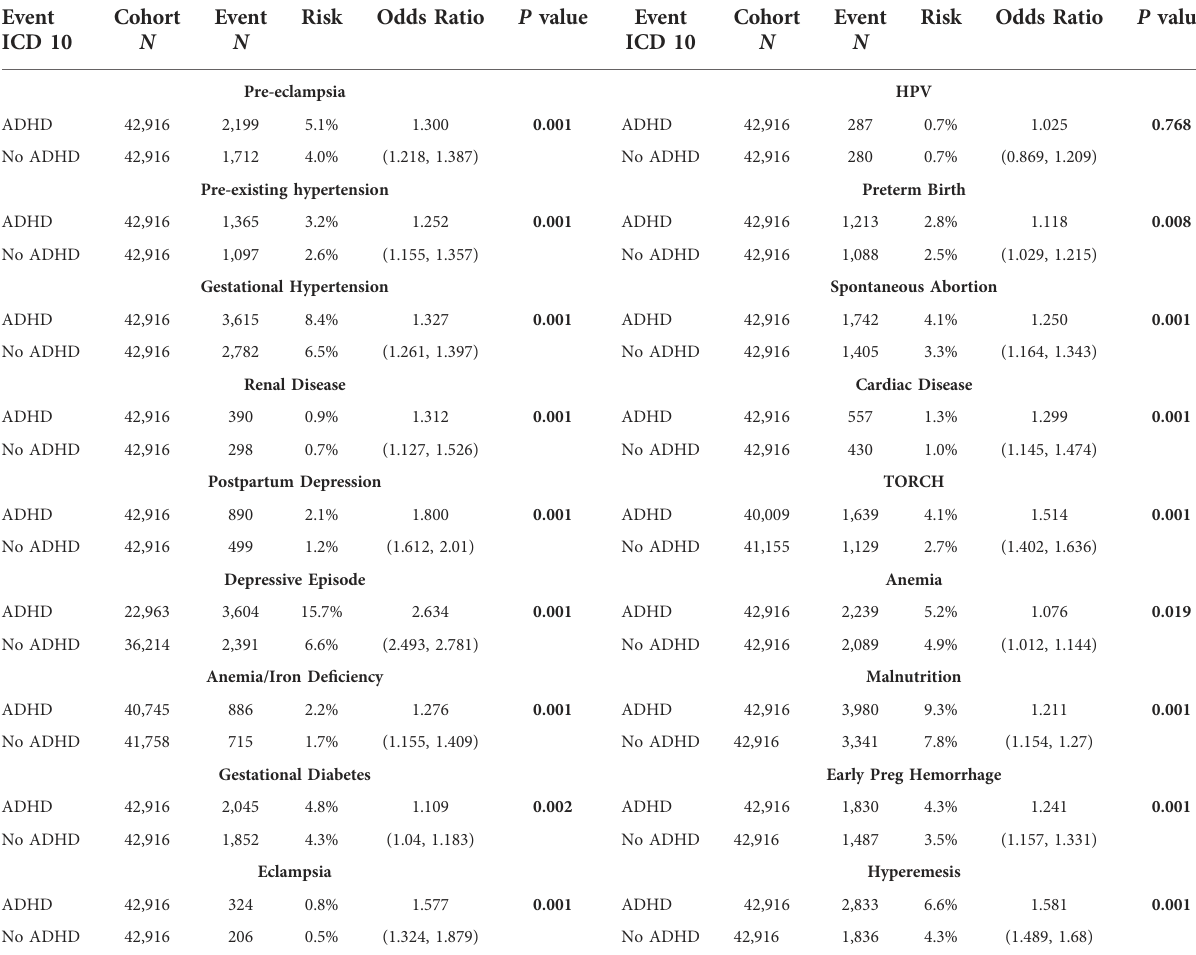
TABLE 1 Event statistics by cohort including cohort N, outcome N, absolute risk, relative risk, odds ratio with 95% CI, and t -test P